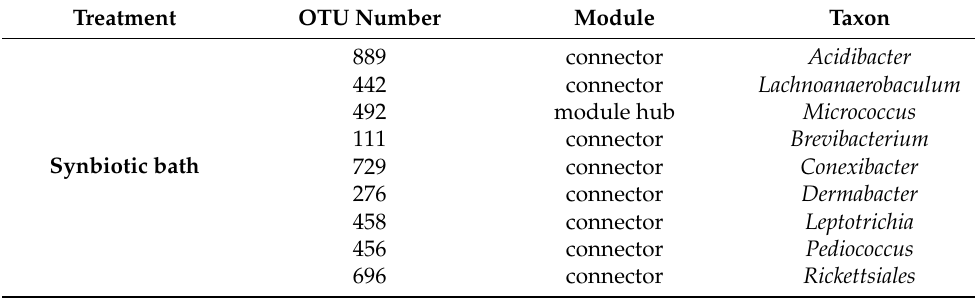
Table 2. Taxonomic classification and topological role of OTUs of the three co-occurrence networks of the bacterial skin microbiome retrieved from AD patients after 14 days of daily synbiotic, prebiotic or placebo bath treatment. OTUs of the network were assigned to connectors, module hubs or network hubs according to Olesen et al. (2007) [29] (see also Figure